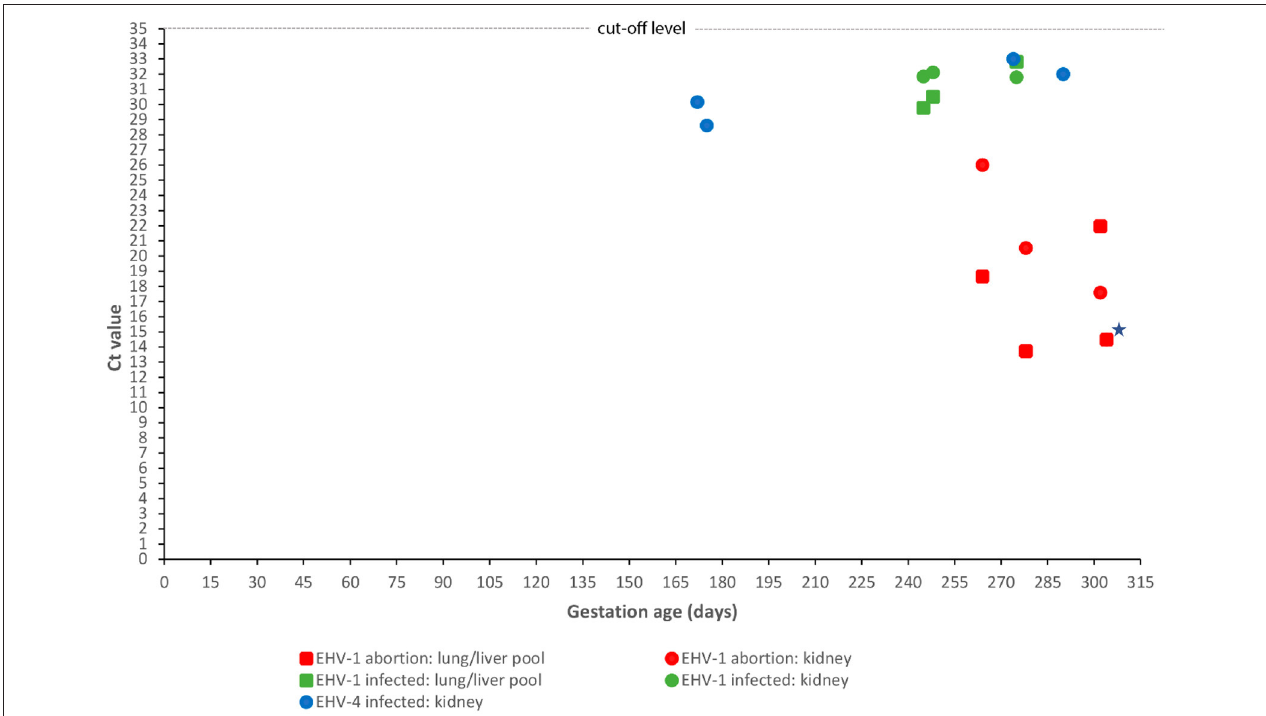
FIGURE 4 | Correlation between fetal age at abortion or premature stillbirth and fetal viral load. Gestational age at abortion or premature stillbirth for 12 equine fetuses infected with either equid alphaherpesvirus type 1 (EHV-1) ( n = 8) or type 4 (EHV-4) ( n = 4) and Ct values obtained by real-time polymerase chain reaction of a kidney sample or a pool of lung and liver samples. Ct values for the pooled lung/liver samples for EHV-4 are not shown as all samples were negative, i.e., had a Ct value above 35. EHV-1 results have been divided into two groups: cases aborted due to EHV-1 and cases infected with EHV-1 but aborted due to another cause. A single case had equal Ct values in the kidney and pooled lung/liver samples (indicated by a